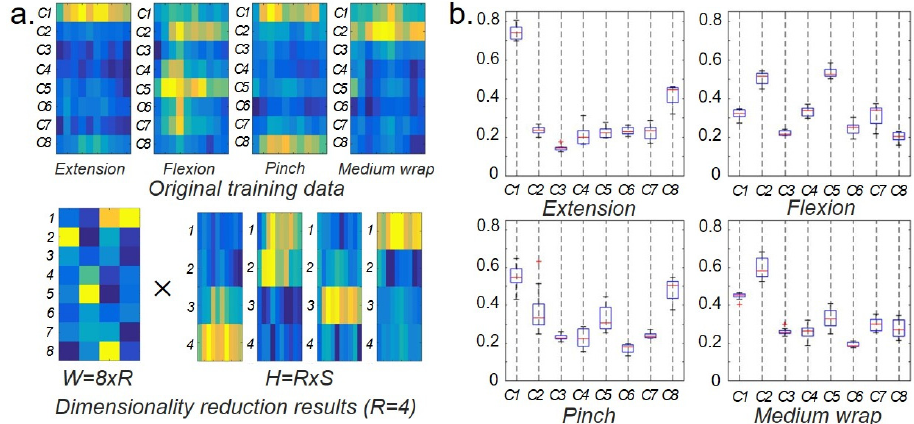
Figure 21. ( a , b ) Distribution characteristics of the training data for the four gestures. Figure 21. Functional verification of training system. ( a ) Dimension reduction analysis of Myo EMG signal. ( b ) Distribution characteristics of the training data for the four